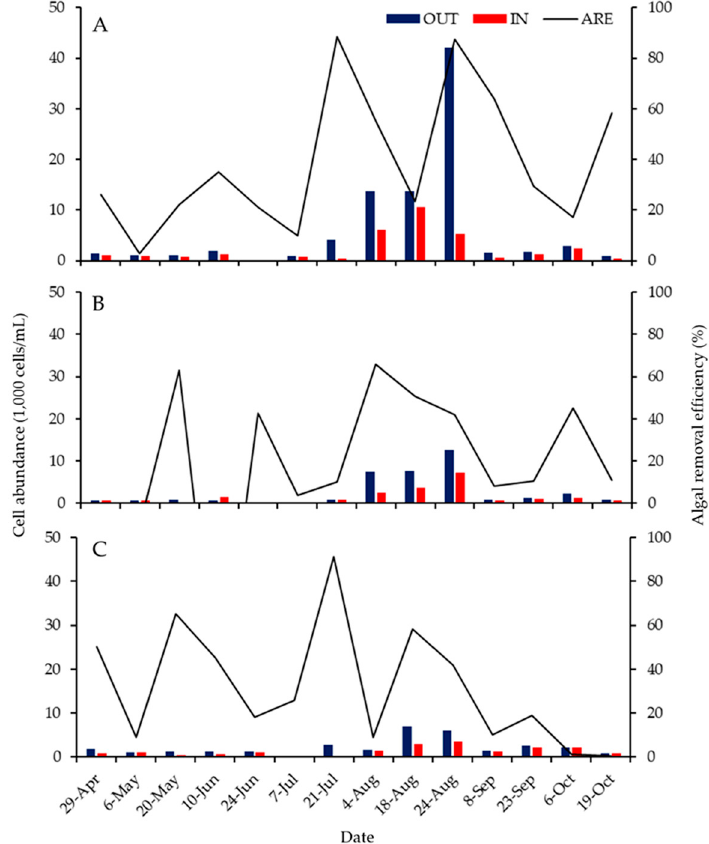
Figure 4. Blocking e ffi ciency of phytoplankton class by study period. Average blocking e ffi ciency of phytoplankton by the alternative algae-blocking mat (ABM). OUT, reservoir water; IN, ABM-passed water. ( A ) Surface layer (0–2 m), ( B ) middle layer (3–5 m), and ( C ) bottom layer (>5 m).